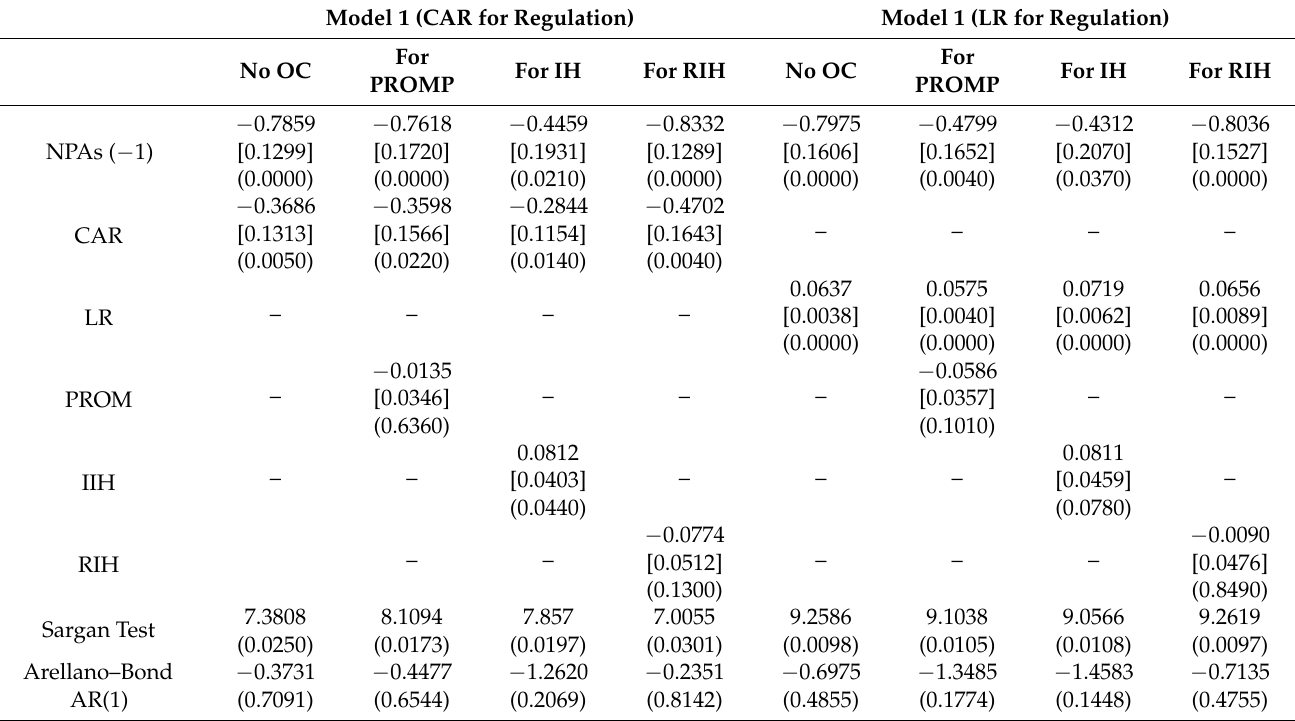
Table 3. Regression results: NPAs as a dependent variable on